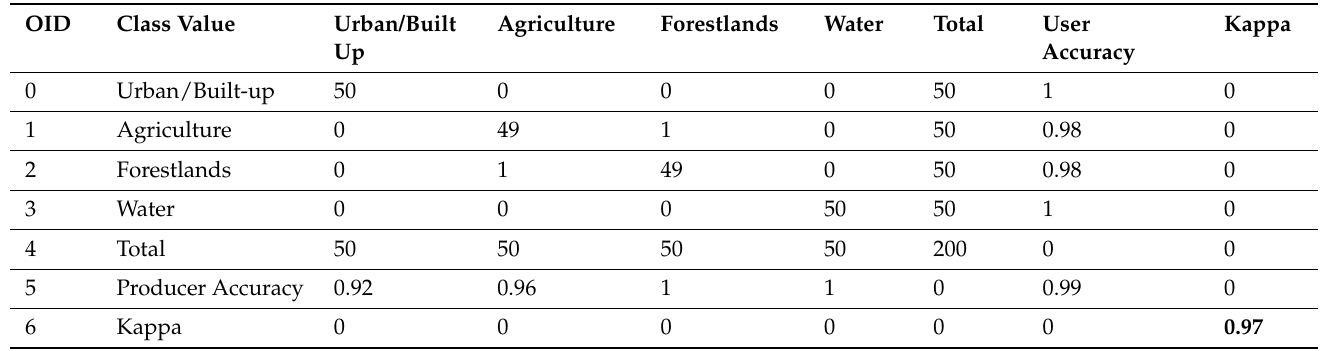
Table A3. User, Producer, and Kappa statistics for the classified image of